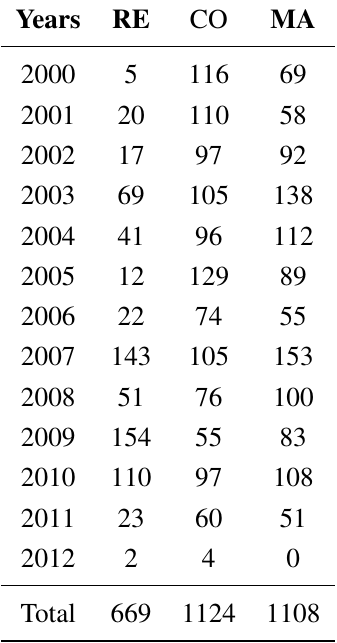
Table 5. Claim counts by year and occupancy: Residential (RE), Commercial (CO), Manufacturing